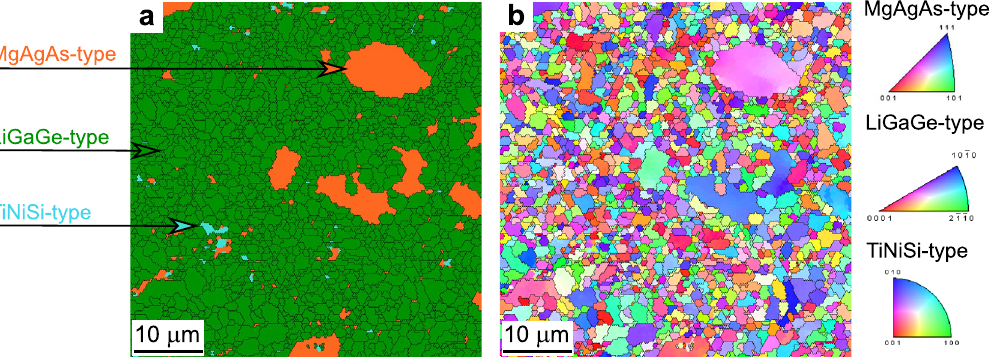
◦ C. Orange, green and cyan